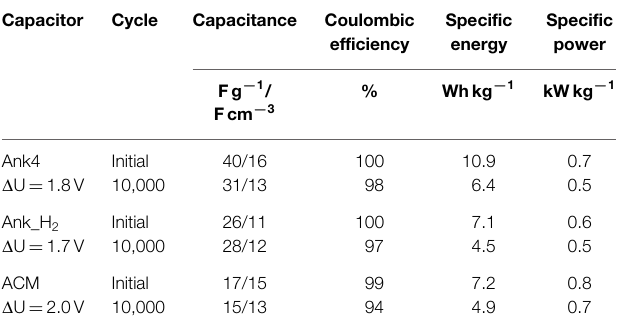
TABLE 3 | Performance parameters for the supercapacitor cells in charge–discharge cycles at 1Ag (cid:0) 1 . Capacitor